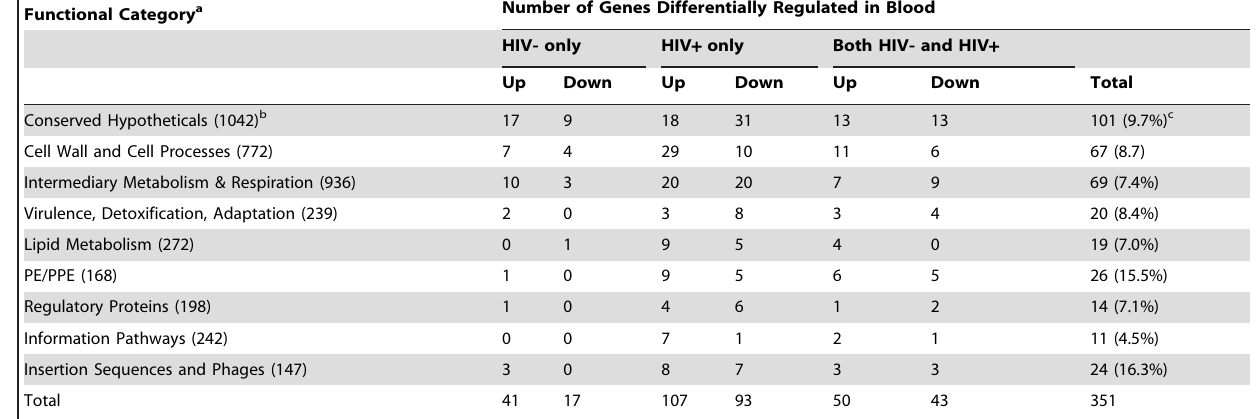
Functional Category a Number of Genes Differentially Regulated in Blood HIV- only